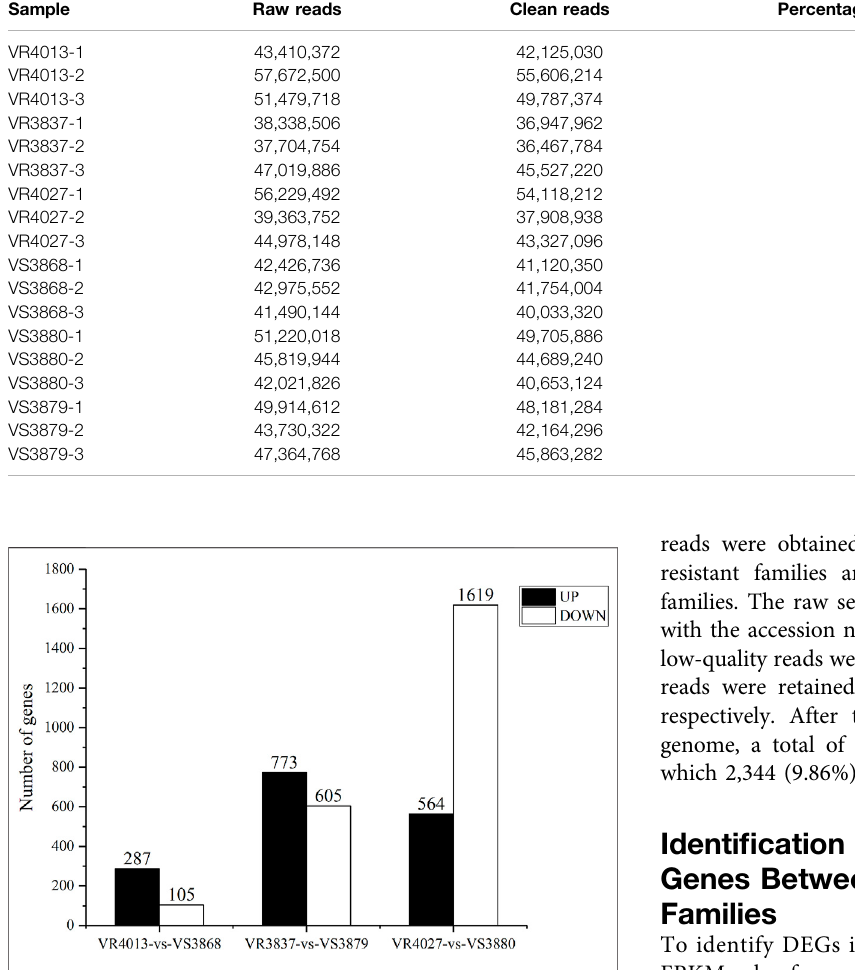
TABLE 2 | Summary of transcriptome sequencing and assembly of the transcriptome from Litopenaeus vannamei . Sample Raw reads Clean reads Percentage remained (%)